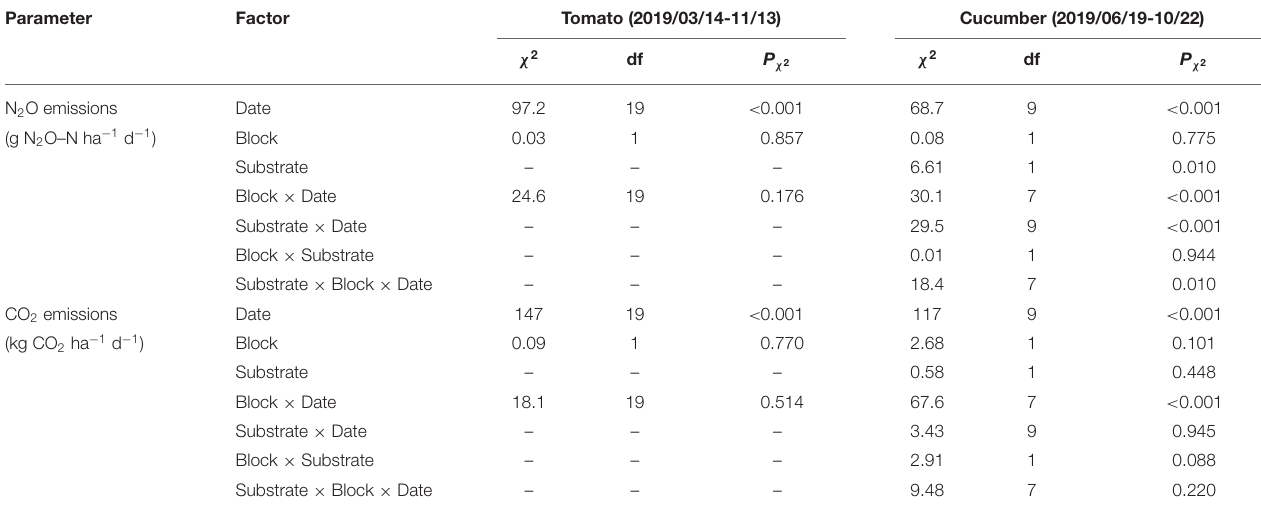
TABLE 1 | Results of linear mixed-effects models analyzing the fixed effects of location inside the greenhouse (Block) and the utilization of new or re-used rock wool growing bags (Substrate, for cucumber cultivation only), and the random effects of individual growing bags on N 2 O and CO 2 emission rates from 2019. Parameter